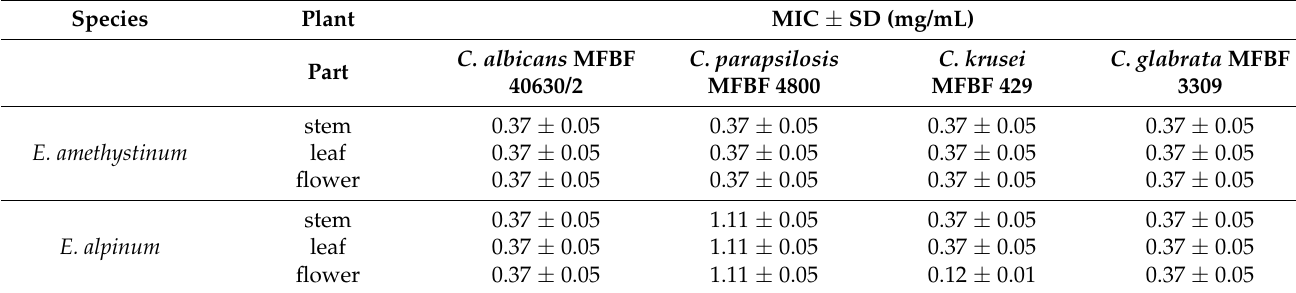
Table 5. Antimicrobial activity of prepared methanolic extracts of Eryngium amethystinum and E. alpinum . Species